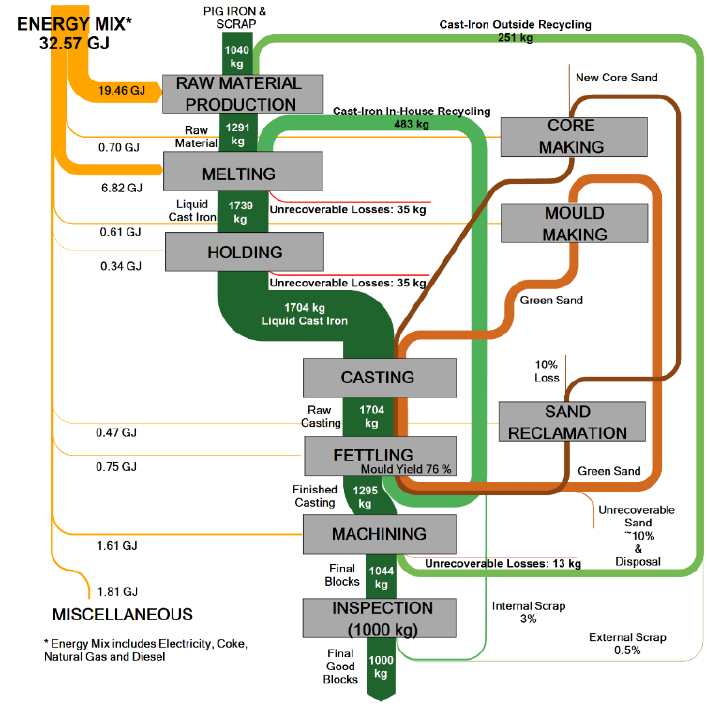
Figure 15. Energy and material flow in CI sand casting, showing that 1000 kg of good castings require the melting of 1739 kg of CI and 32.57